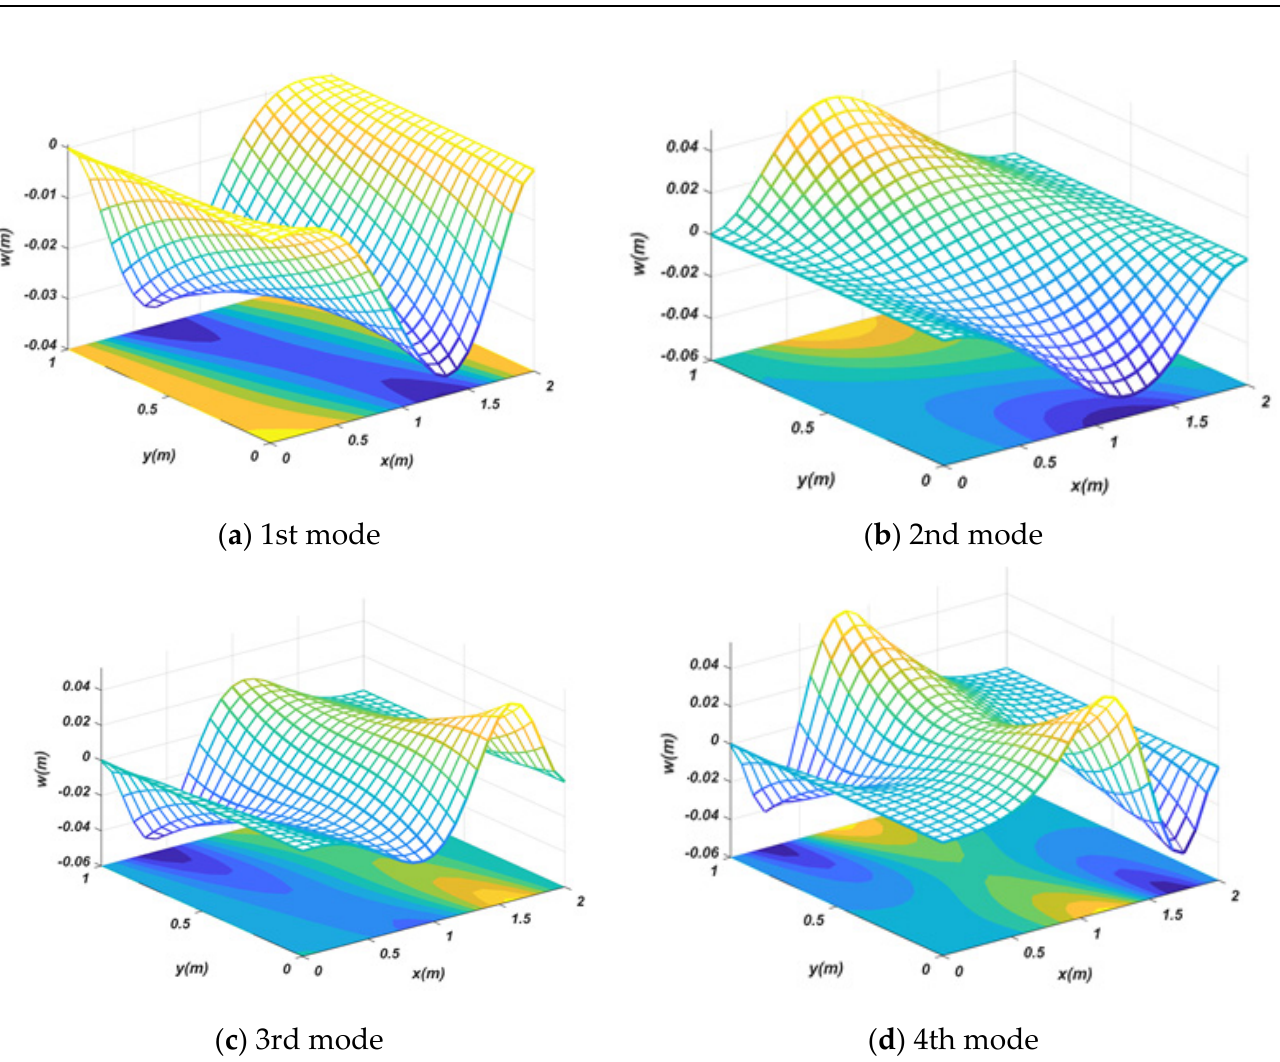
Figure 4. First four buckling mode shapes of a FG-saturated porous plate subjected to a shear load (CFCF, a = 2 m, b = 1 m).